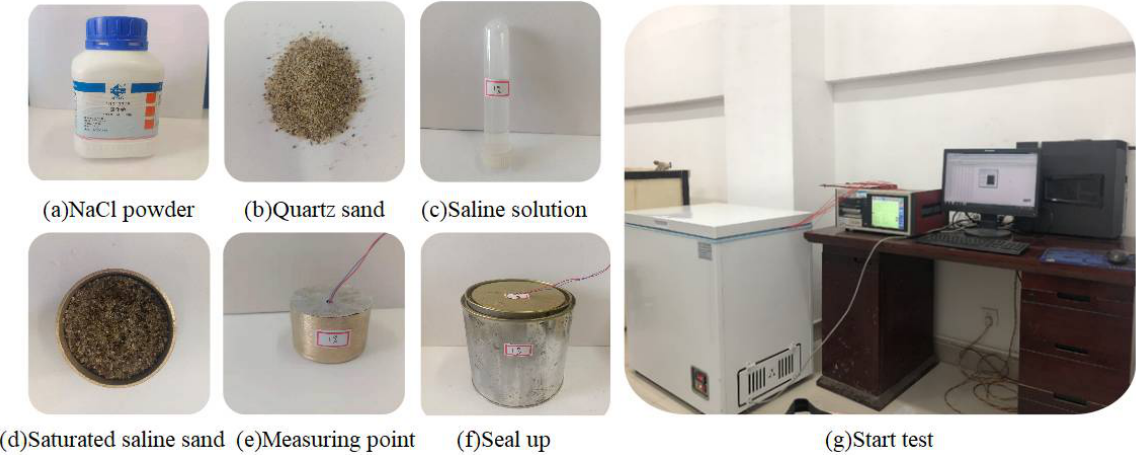
Figure 2. Test system and test procedure.